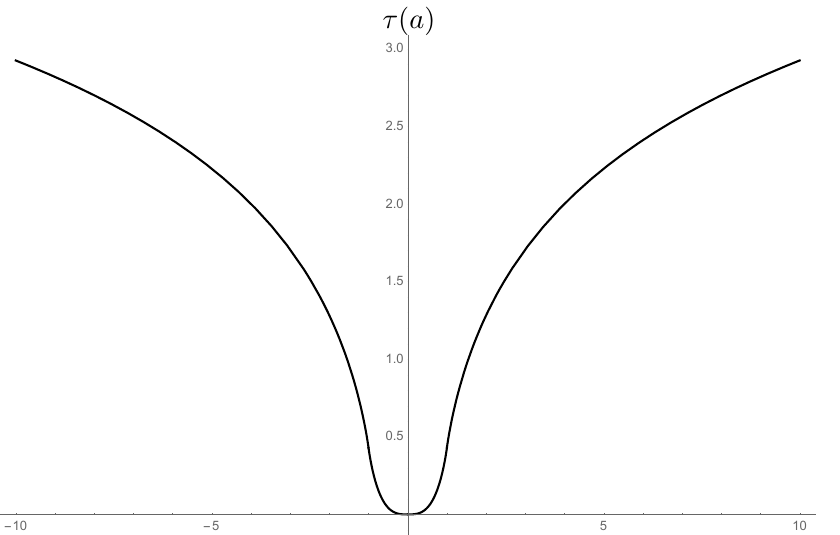
Figure 3. The dynamics across the singularity is regular due to inverse volume corrections. In this picture, we show the function τ ( a ) , defining the dynamical evolution across the singularity, in the case of Thiemann’s regularization of the